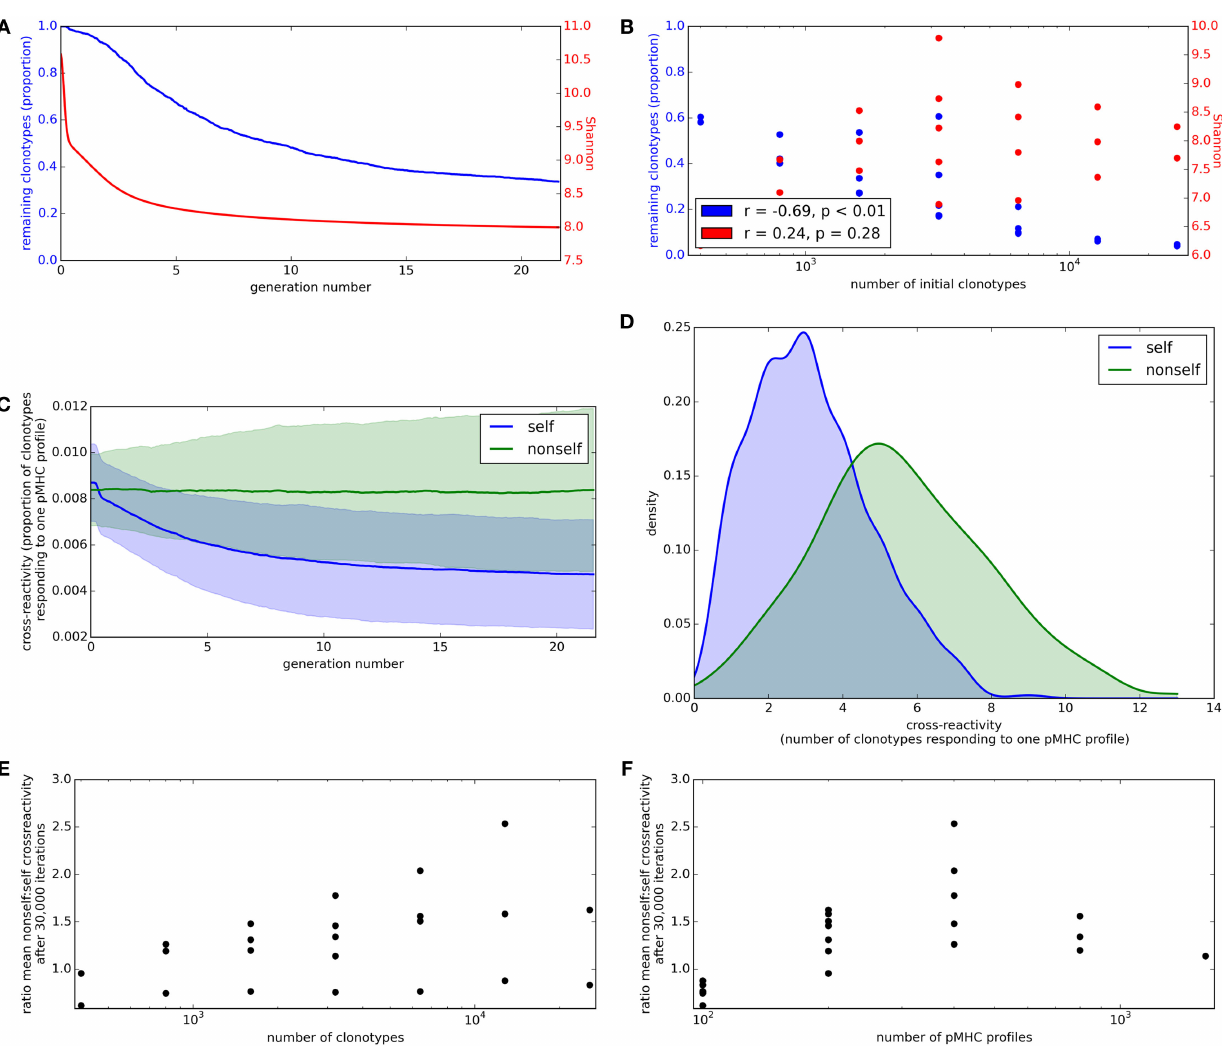
(D) Distribution of cross-reactivity across all self (blue) and non-self (green) pMHC profiles after 30,000 iterations of the update algorithm with N = 3,200 and M = 400. Cross-reactivity is measured as the absolute number of present clonotypes that have non-zero binding strength to a profile. (E) Relationship between the number of clonotypes present at the start of the update algorithm and the ratio of the mean cross-reactivity against non-self profiles to the mean cross-reactivity against self profiles after 30,000 cycles of the update algorithm. (F) Relationship between the number of self profiles in the update algorithm and the ratio of the mean cross-reactivity against non-self profiles to the mean cross-reactivity against self profiles after 30,000 cycles of the update algorithm. Other model parameters for all panels are: self-response threshold (cid:28) = 1, growth rate (cid:23) = ln 2 (cid:14) t –1 , learning rate (cid:17) = 0.002001 (cid:14) t –1 and proportion of non-zero affinities (cid:13) =